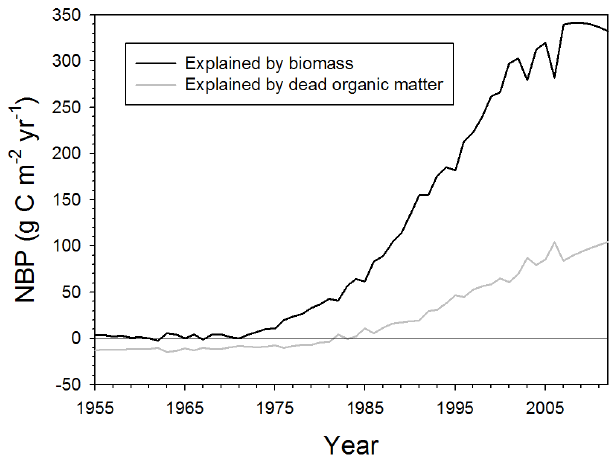
Figure 6. The time series of net biome production (NBP) in South Korean forests during the simulation period. Carbon (C) sequestra- tion by biomass and dead organic matter C stocks in South Korean forests rapidly increased and showed an upward